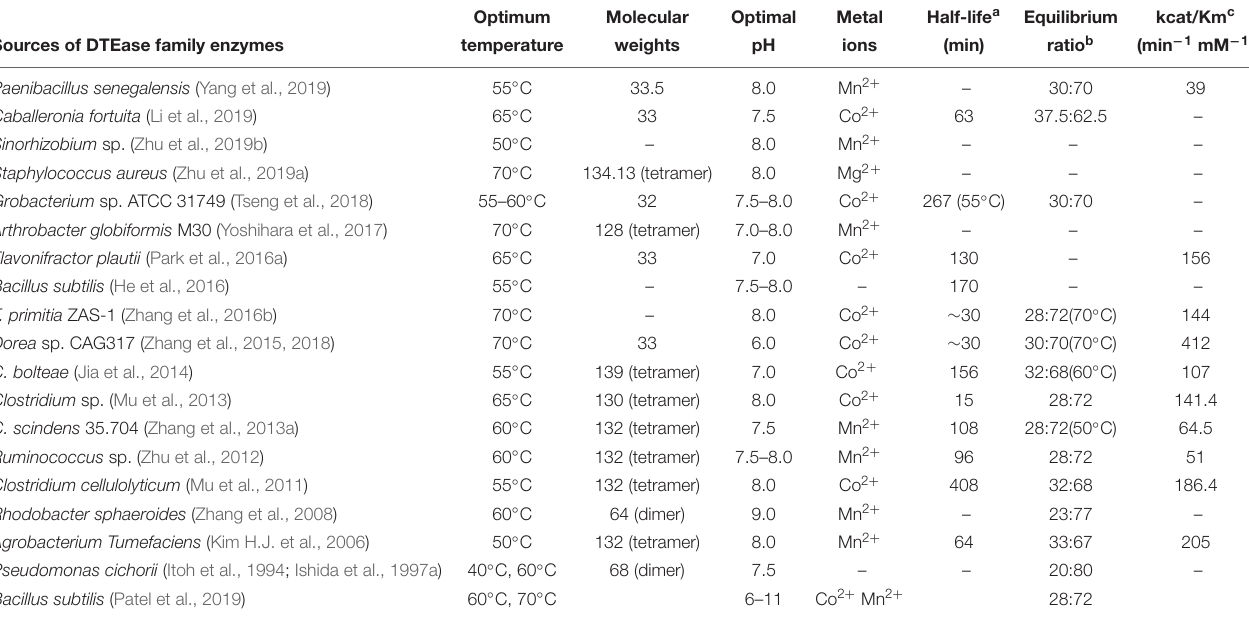
TABLE 1 | Properties of DTEase family